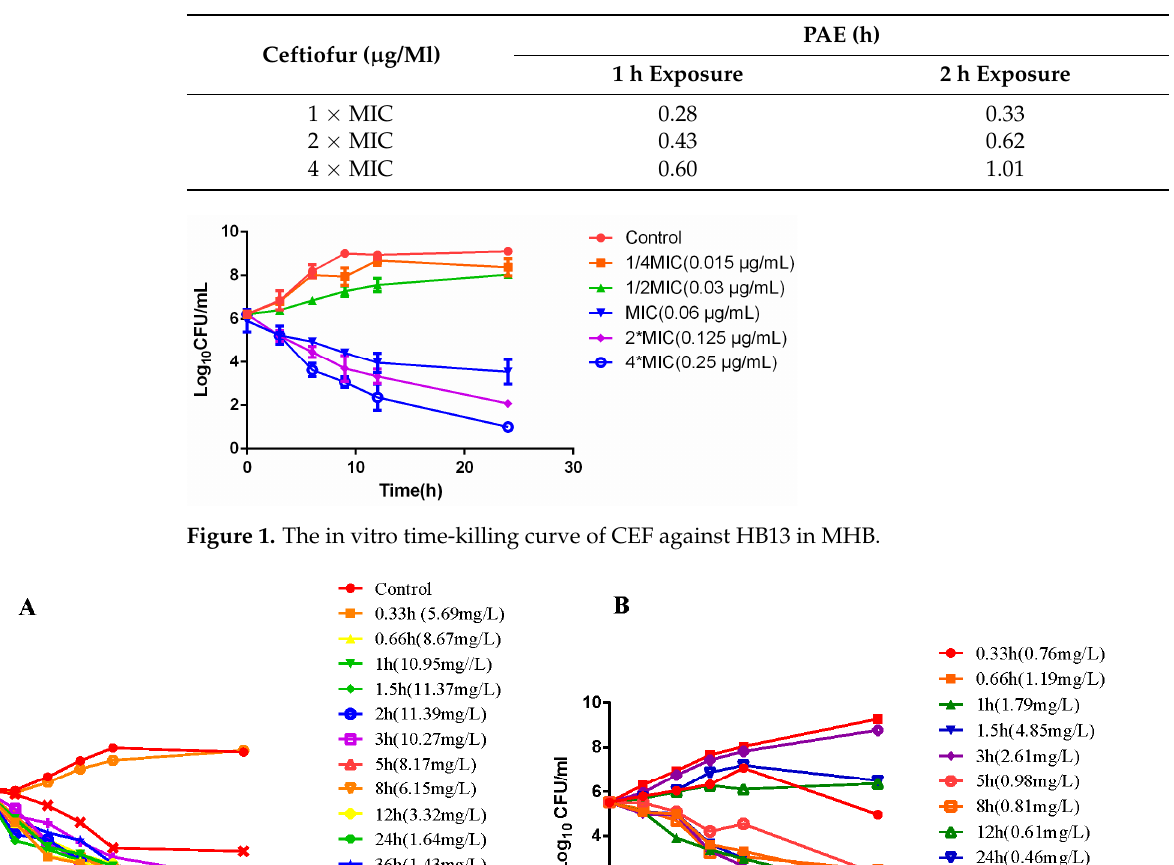
Table 1. Post antibiotic effect (PAE) of CEF against P. multocida after 1 h and 2 h.